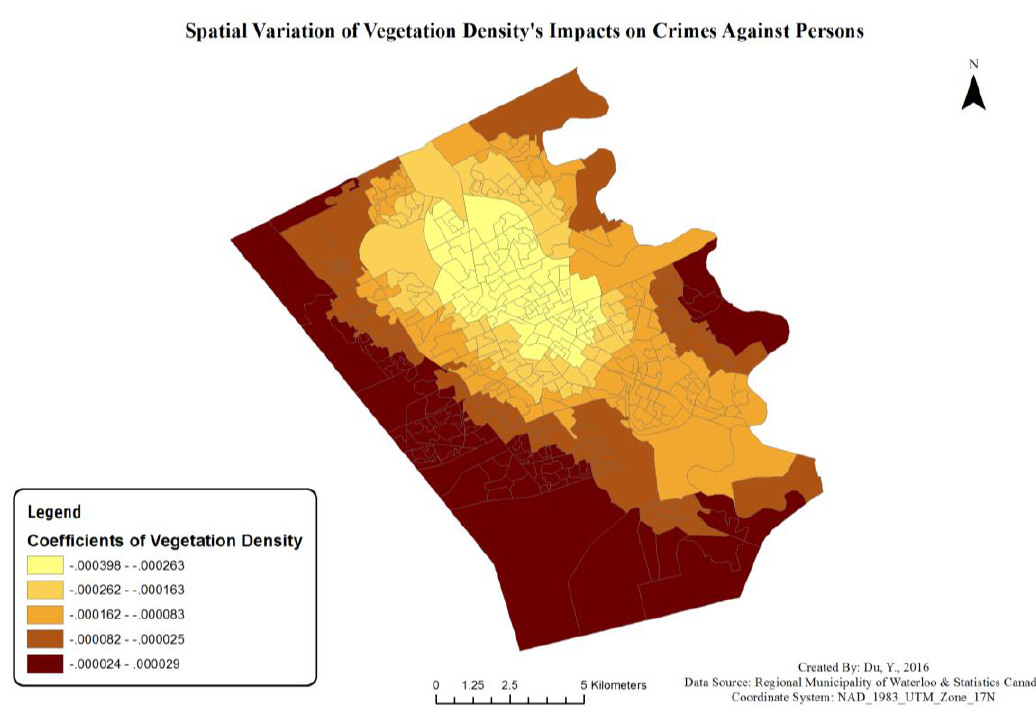
Figure 6. Vegetation density’s impact on crimes against persons.